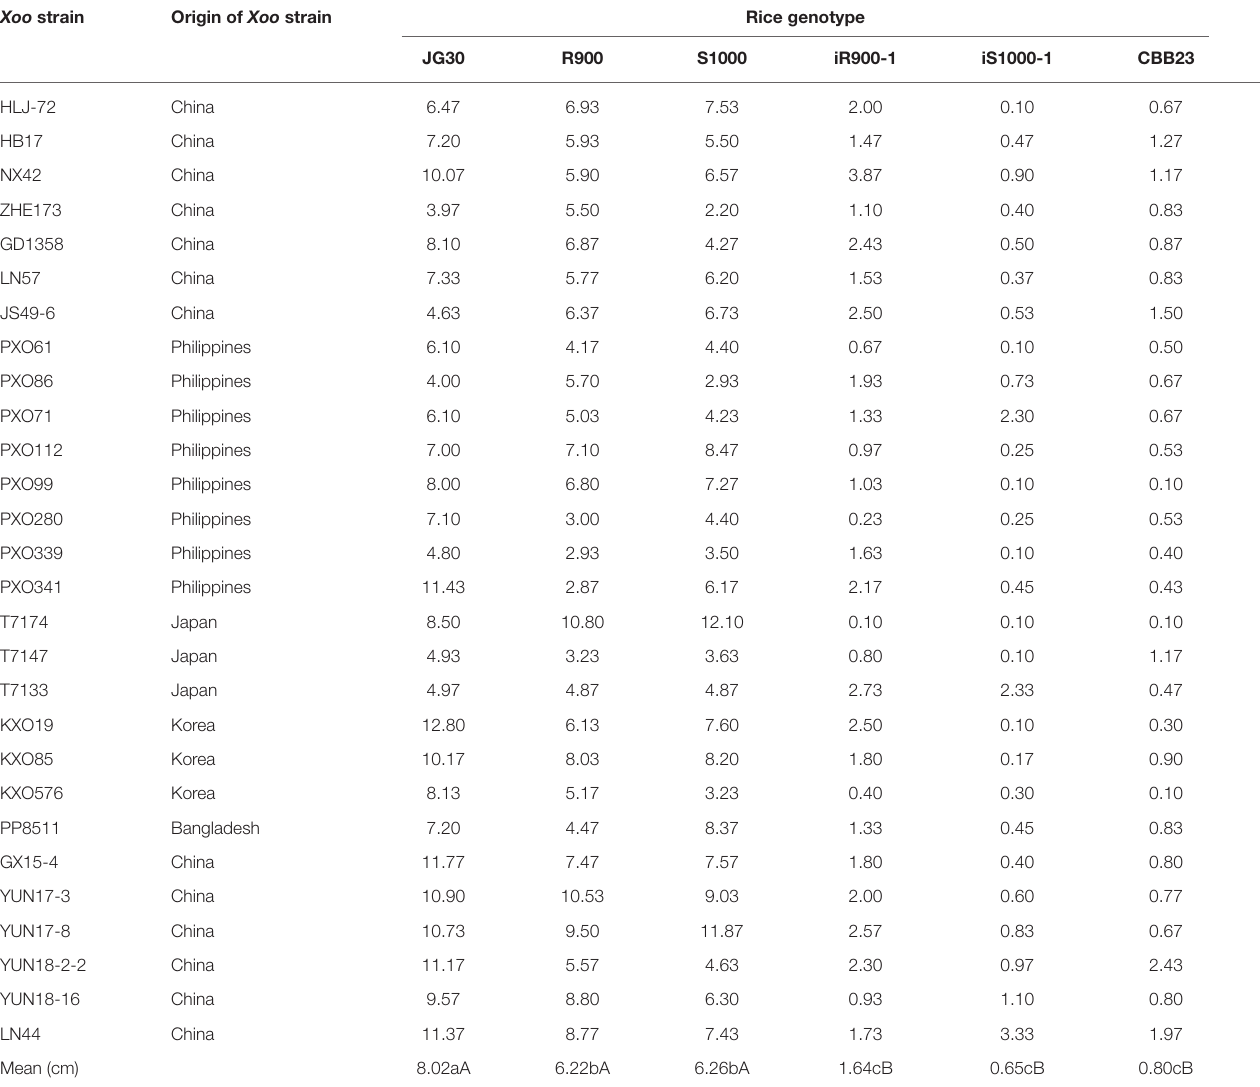
TABLE 1 | Resistance assessment of rice genotypes against 28 Xoo strains a